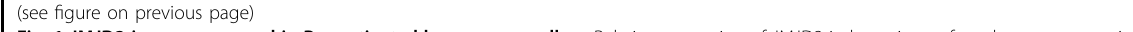
Fig. 1 JMJD3 is overexpressed in Ras-activated lung cancer cells. a Relative expression of JMJD3 in lung tissues from lung cancer patients and normal (normal n = 27, lung cancer n = 27). *** P < 0.001 versus normal. b Overall survival rate curve of lung cancer patients according to JMJD3 expression (low n = 484, high n = 1442). c Correlative expression of JMJD3 compared to K-ras in lung tissues. d Correlative expression of JMJD3 compared to H-ras in lung tissues. e Real-time RT-PCR (left panel) and western blot analysis (right panel) of JMJD3 expression levels in BEAS-2B cells transfected with K-Ras V12 or H-Ras V12 expression vector. Columns, mean of three independent experiments performed in triplicate; bar , S.D.; ** P < 0.01 versus control. f Real-time RT-PCR (left panel) and western blot analysis (right panel) of JMJD3 expression levels in BZR cells transfected with control or H-Ras N17 expression vector. Columns, mean of three independent experiments performed in triplicate; bar , S.D.; ** P < 0.01 versus control. g Real- time RT-PCR (left panel) and western blot analysis (right panel) of JMJD3 expression levels in normal (BEAS-2B cells) and Ras-activated lung cancer cells (A549, H358, H1299, and BZR cells). Columns, mean of three independent experiments performed in triplicate; bar , S.D.; * P < 0.01 versus BEAS-2B. h Western blot analysis of H3K27me3 in BEAS-2B, A549, H358, H1299, and BZR cells. i Immuno fl uorescence analysis of expression and localization of JMJD3 (green) in A549 cells treated with DMSO, LY294002 (10 μ M), or U0126 (10 μ M). DAPI-staining nuclei (blue) were also shown. Scale bar, 20 μ m. j Expression of JMJD3 in cytosolic or nuclear fractions of A549 cells treated with DMSO, LY294002 (10 μ M), or U0126 (10 μ M). PARP (nucleus) and tubulin (cytoplasm) were also shown. k Expression level of JMJD3 in BZR, A549, and H1299 cells transfected with the increasing amount of DN-MEK1 expression vector. l Expression level of JMJD3 in BZR, A549, and H1299 cells transfected with the increasing amount of DN-AKT1 expression